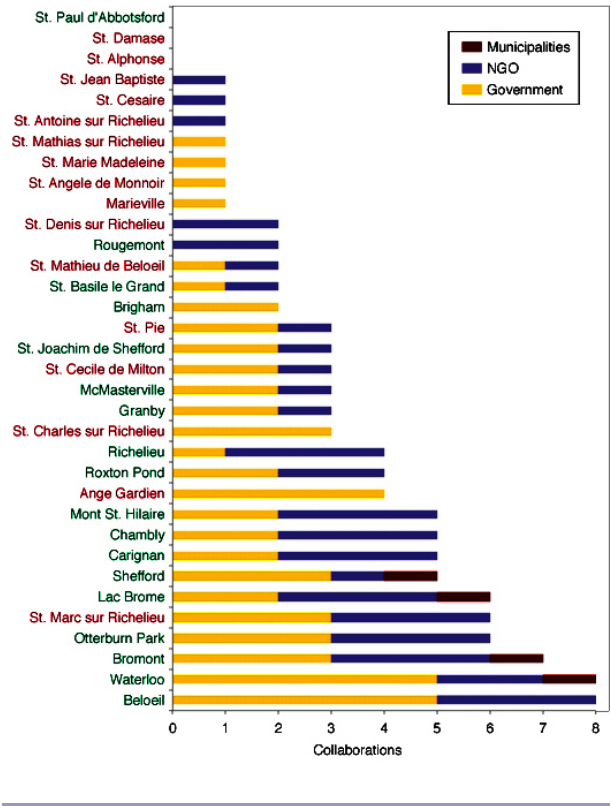
Fig. 4 . Municipalities exhibit a wide range of collaborative behavior. The range includes municipalities that are not connected to others, through to municipalities that are connected to several bridging organizations and other municipalities. Yellow indicates the number of collaborations a municipality reported with government agencies, blue demonstrates the number of collaborations a municipality reported with nongovernmental organizations, and red indicates the number of collaborations municipalities have with other municipalities. This figure demonstrates that municipalities maintain both a range in collaborative behavior, as well as collaboration with a diversity of actor group types, i.e., government, NGO, municipality.